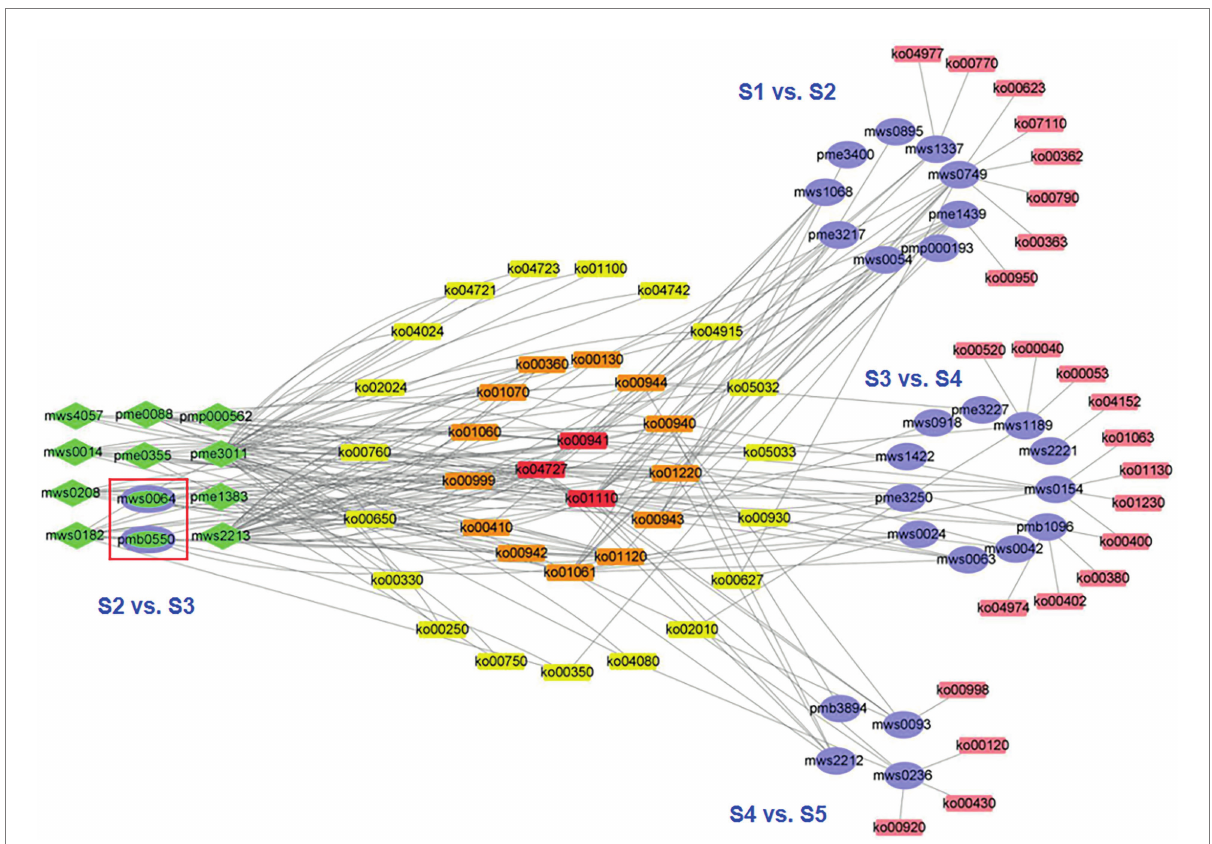
FIGURE 4 Network visualization of the differential metabolites and metabolic pathways during five developmental stages of the flowers of S. japonica . The purple ovals represent the unique differential metabolites for each comparison, green diamonds or ellipses represent the differential metabolites corresponding with multiple comparisons, and green-filled ovals (purple border) represent the differential metabolites for the comparison of stages 2 and 3 (S2 vs.